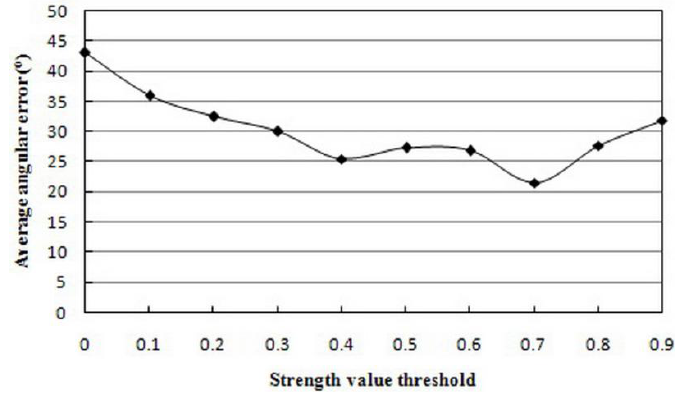
Figure 4. Average angular error versus strength value